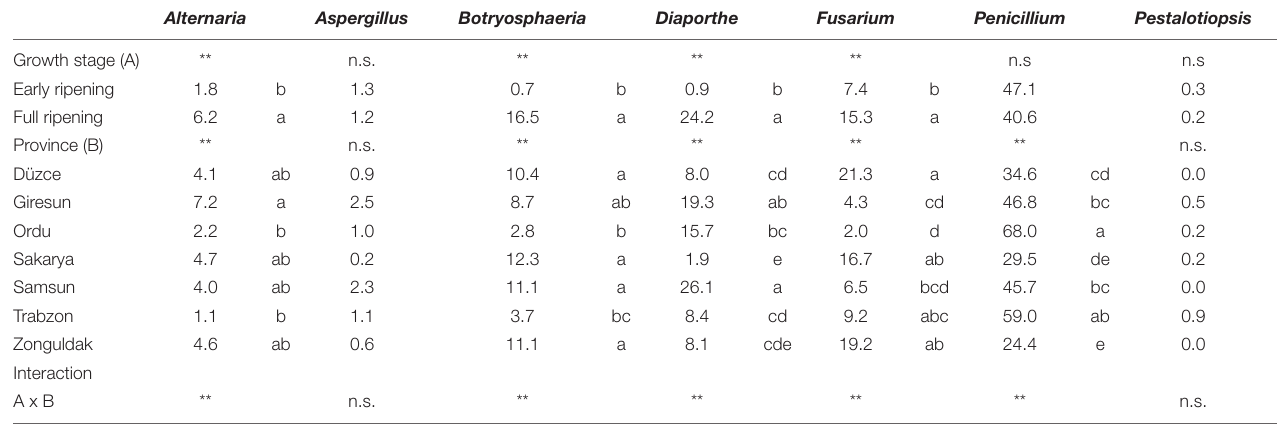
TABLE 4 | Mean incidence of the most isolated fungal genera in hazelnuts sampled at early and full ripening in 7 Turkish provinces (Düzce, Giresun, Ordu, Sakarya, Samsun, Trabzon and Zonguldak). Growth stage and province were considered as factors in ANOVA. Alternaria Aspergillus Botryosphaeria